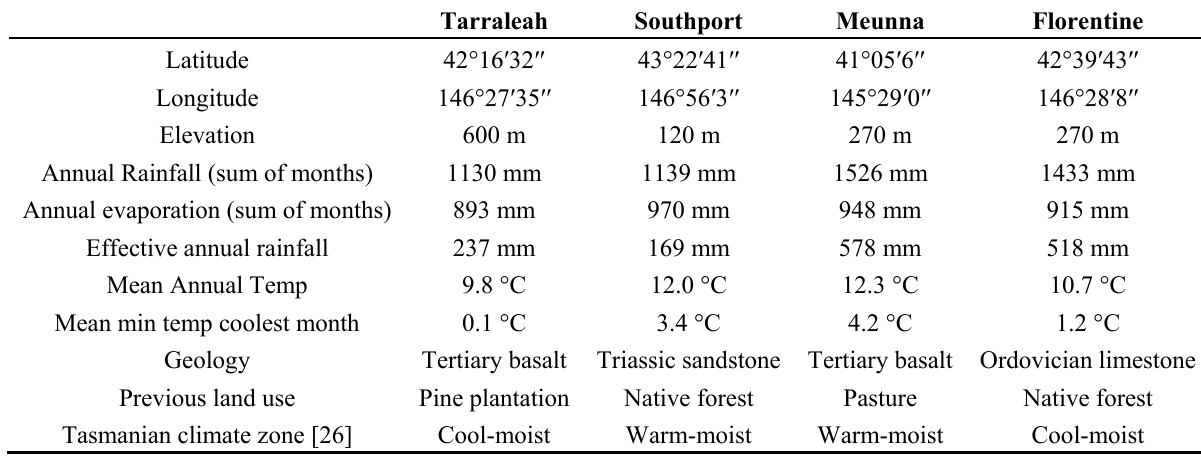
Table 1. Geographic and climatic details of the four Eucalyptus nitens progeny trials. Climatic data were estimated using the climatic surfaces in ANUCLIM, module MNTHCLIM